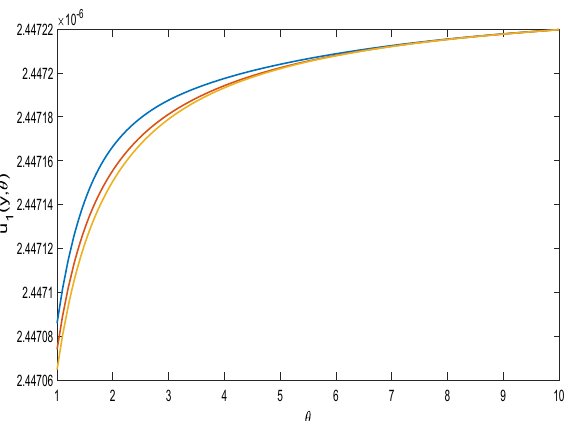
Fig. 4 Graphical representation of the dimensionless piezometric head w.r.t. dimensionless time at distance y = 5.5. for various η and ζ values such that ηζ = 50 and fractional order α = 0 . 90 , β = 0 . 90